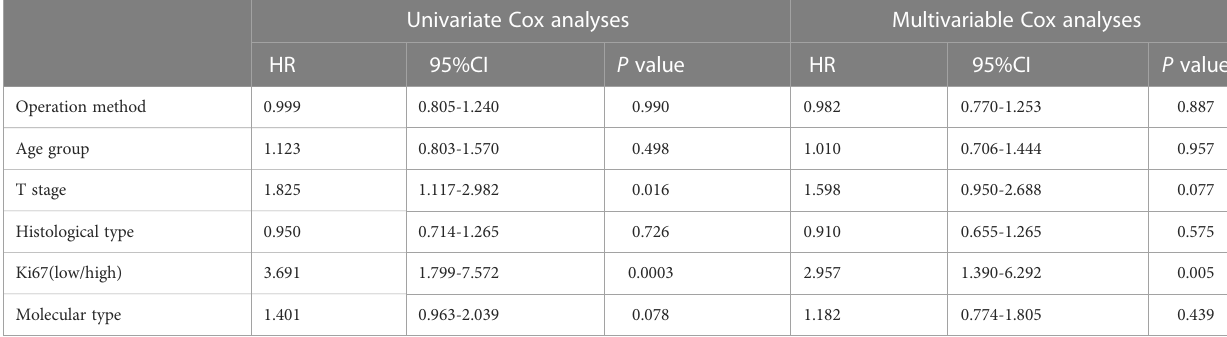
TABLE 3 Univariate and Multivariable Cox analyses of operation method and other clinical characteristics on distant recurrence.